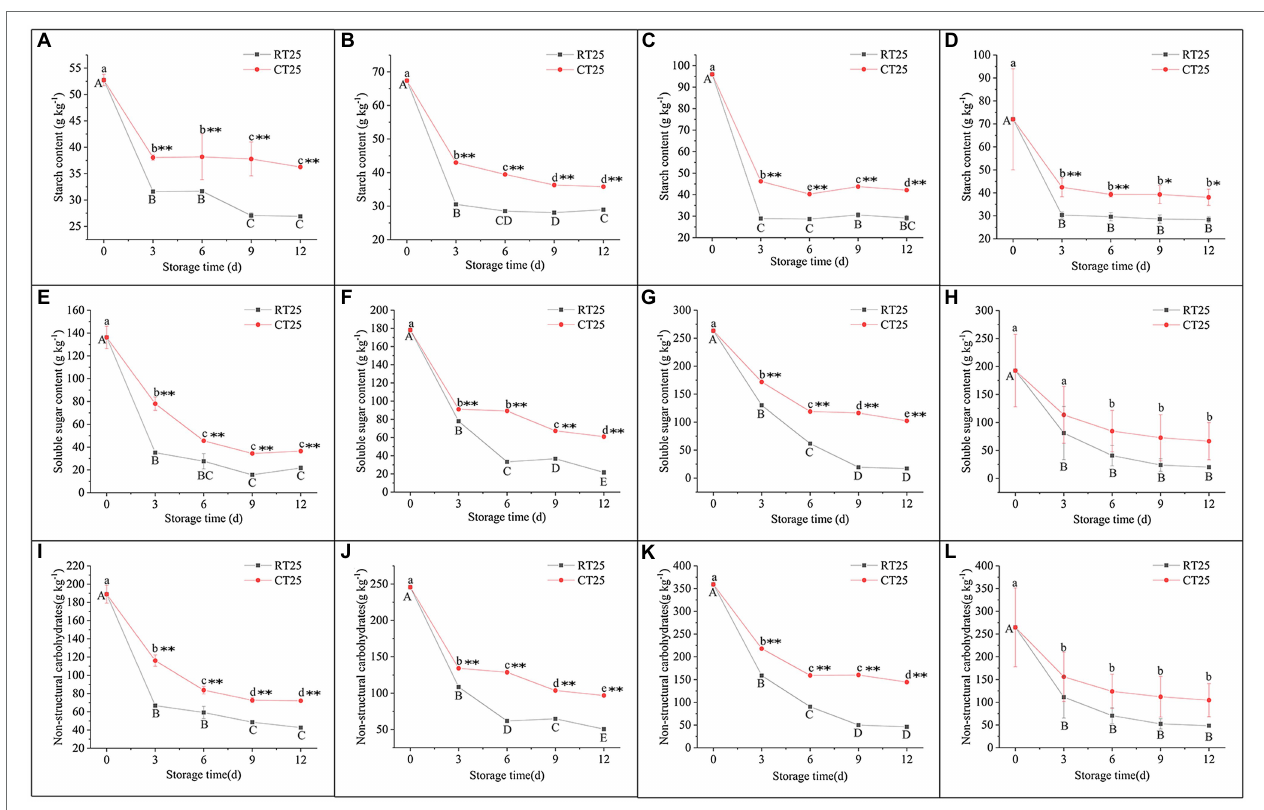
FIGURE 6 | Dynamic changes in the content of starch, soluble sugar, and nonstructural carbohydrate (NSC) in bamboo shoots during storage at 25 ° C and 4 ° C. (A–D) Dynamic changes in starch content in shoots during storage for upper (A) , middle (B) , and bottom (C) plant parts, and mean values of all plant parts in bamboo shoots under different treatment conditions (D) . (E–H) Dynamic changes in soluble sugar content in shoots during storage for upper (E) , middle (F) , and bottom (G) plant parts, and mean values for all plant parts in the bamboo shoots (H) . (I–L) Dynamic changes in NSC content in shoots during storage for upper (I) , middle (J) , and bottom (K) plant parts, and mean values for all plant parts in the bamboo shoots (L) . Data are presented as mean ± standard deviation ( n = 3). Significant analysis was performed using the Student’s t -test, in which different letters represent significant difference between treatments within the group, and the asterisk represents the level of significance between groups ( * means the difference is significant at the 0.05 level, ** means the difference is significant at the 0.01